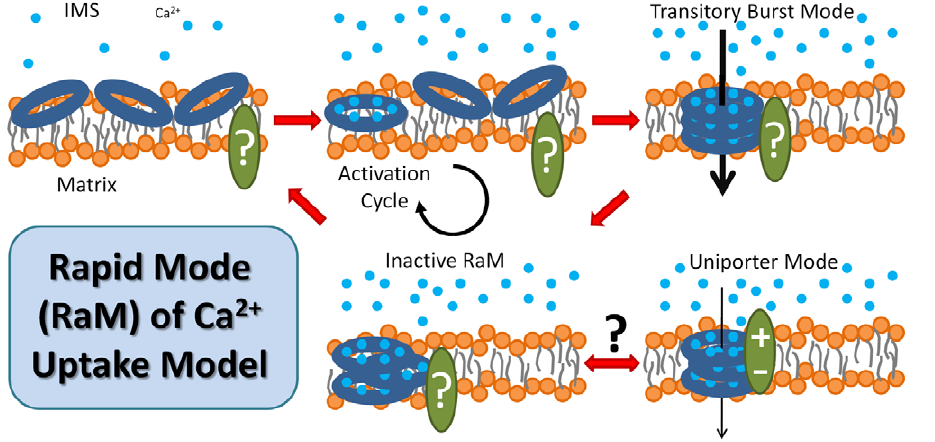
Figure 6. Schematic of the proposed model of the mitochondrial RaM Ca 2 + uptake mechanism. The mechanism is based on that published by Starkov [13]. The model assumes that Ca 2 + is required to initiate an activation cycle where the complex enters a transitory state of high Ca 2 + conductance before entering an inactivated state. While the external Ca 2 + remains elevated, the mechanism either stays locked in this quiescent state or triggers another conformational change eliciting the slow uptake (CU) mode. Once the external Ca 2 + falls below a threshold concentration, the RaM complex dissociates and resets awaiting another trigger pulse of Ca 2 + .